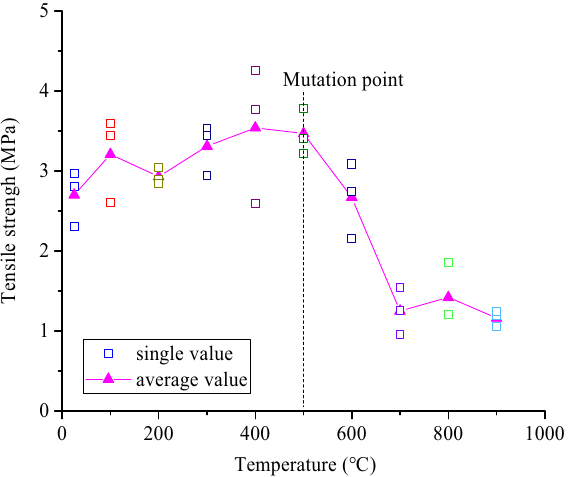
Figure 10. The relationship between the tensile strength of the samples and the treatment temperature.